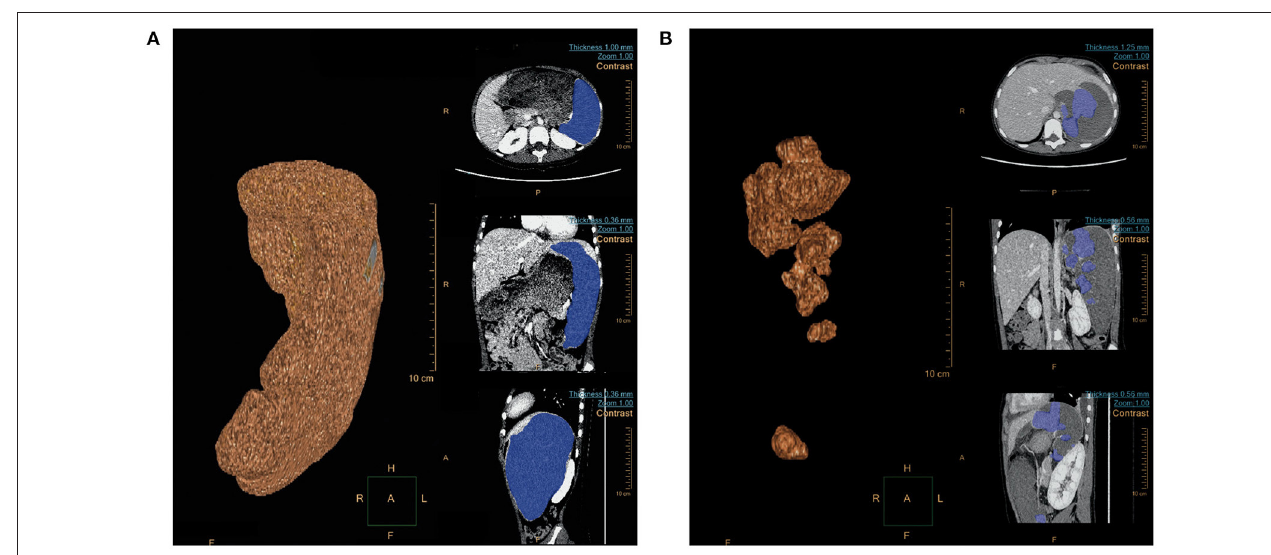
FIGURE 2 | (A) Spleen volume (679.0 cm 3 ) before embolization; (B) Spleen volume (112.2 cm 3 ) 1 week after embolization.